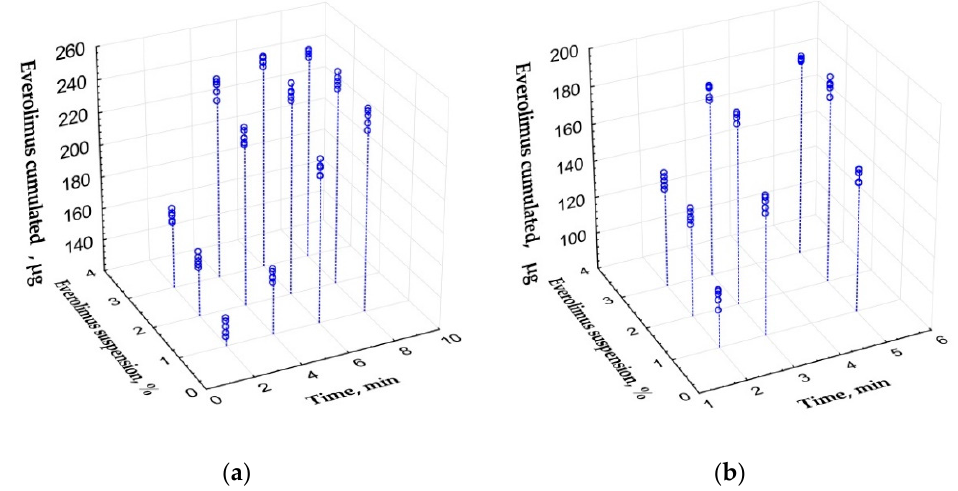
Figure 3. Scatterplot of the amount of cumulated everolimus depending on enrichment conditions (time and everolimus suspension concentration in initial dilutions). ( a ) Porous samples. ( b ) Microfiber samples.